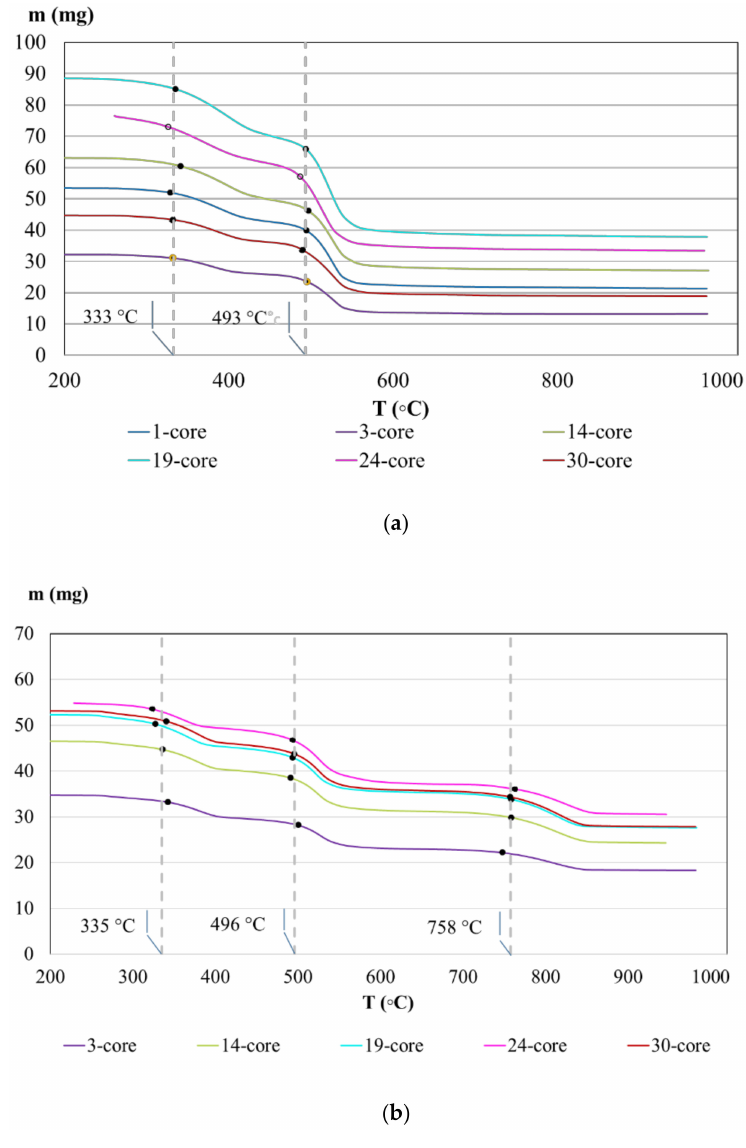
Figure 4. TGA curves of cable materials: ( a ) outer sheaths; ( b )